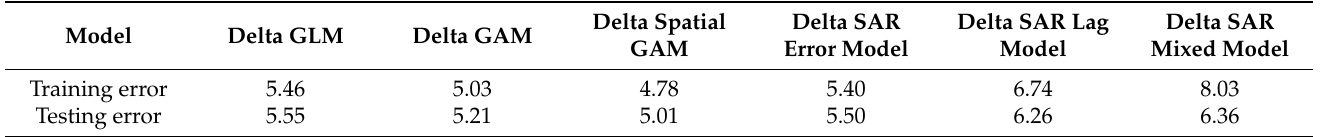
Table 3. Training and test errors from 3-fold cross-validation for six delta models fitted to NEAMAP weakfish survey data after 500